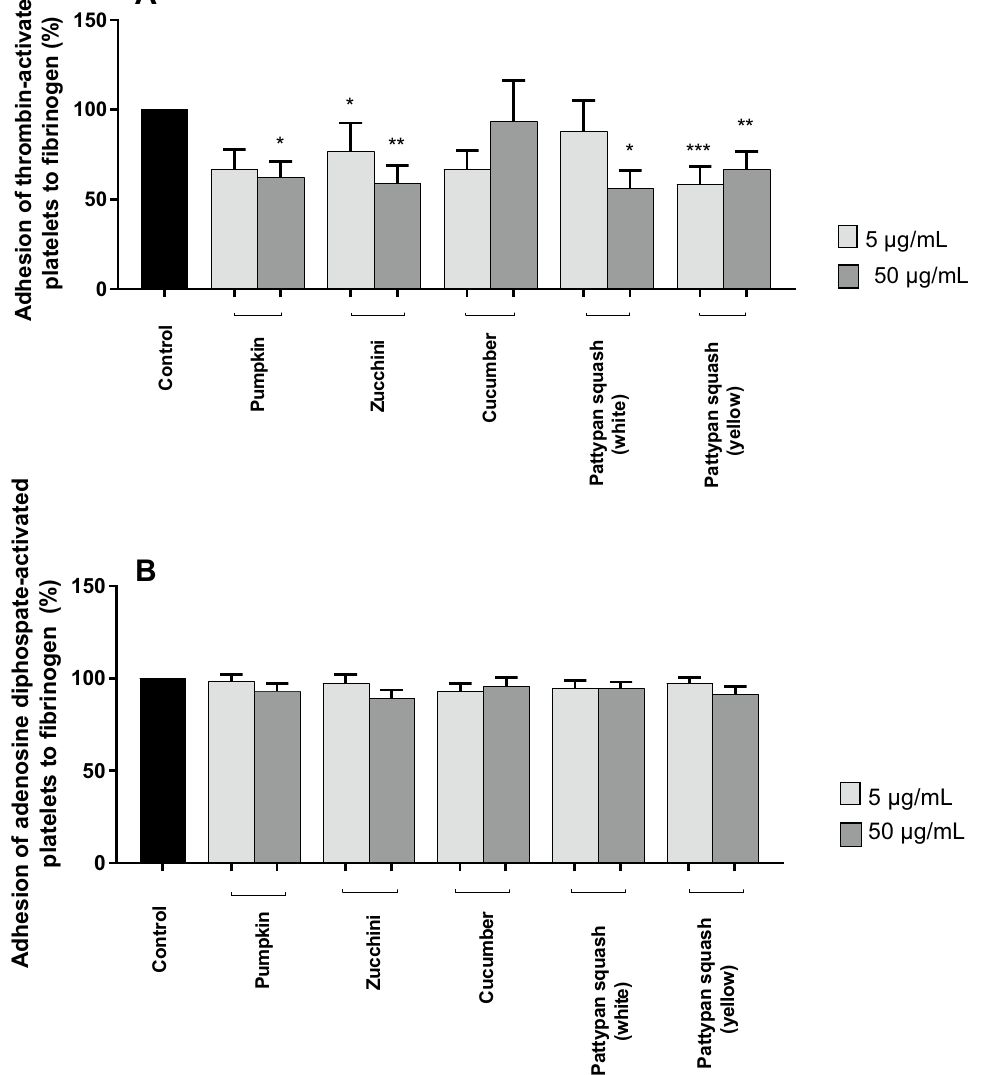
Figure 3. Effects of the five cucurbit vegetable preparations (concentrations 5 and 50 µg/mL, incubation time—30 min) on adhesion to fibrinogen and thrombin (final concentration 0.2 U/mL)—activated platelets ( A ) or ADP (final concentration 30 µM)—activated platelets ( B ). In the graphs, the adhesion is expressed as a percentage of the control sample (platelets without plant preparation). Results are given as mean ± SD (n = 5). Kruskal–Wallis test: *p < 0.05, **p < 0.01, ***p < 0.001, compared with control (i.e. not treated with plant preparation). There wasn’t any statistically significant between effect of 5 and 50 µg/mL. There wasn’t any statistically significant between effect of 5 and 50 µg/mL (p > 0.05). The baseline spectral reading (absorbance) for plant preparations range between 0.0025 and